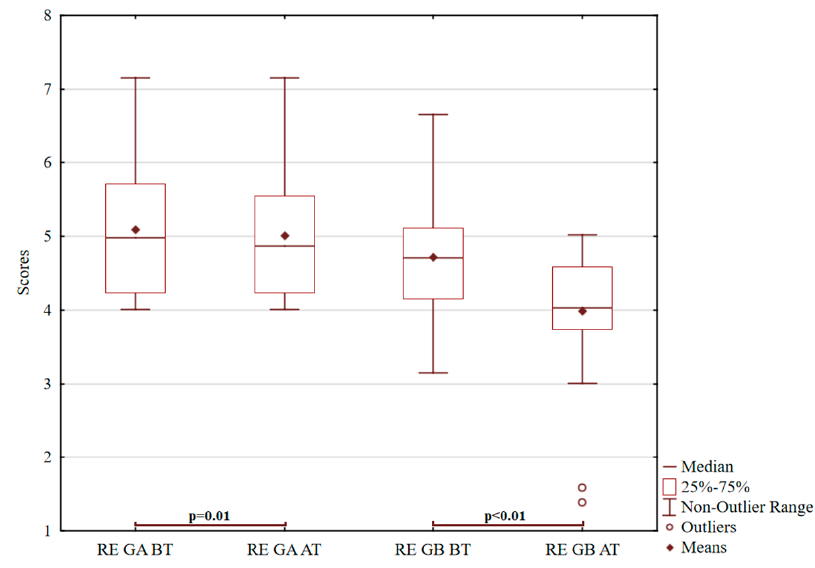
Figure 4. Graf 4 ROR for contact with reality.